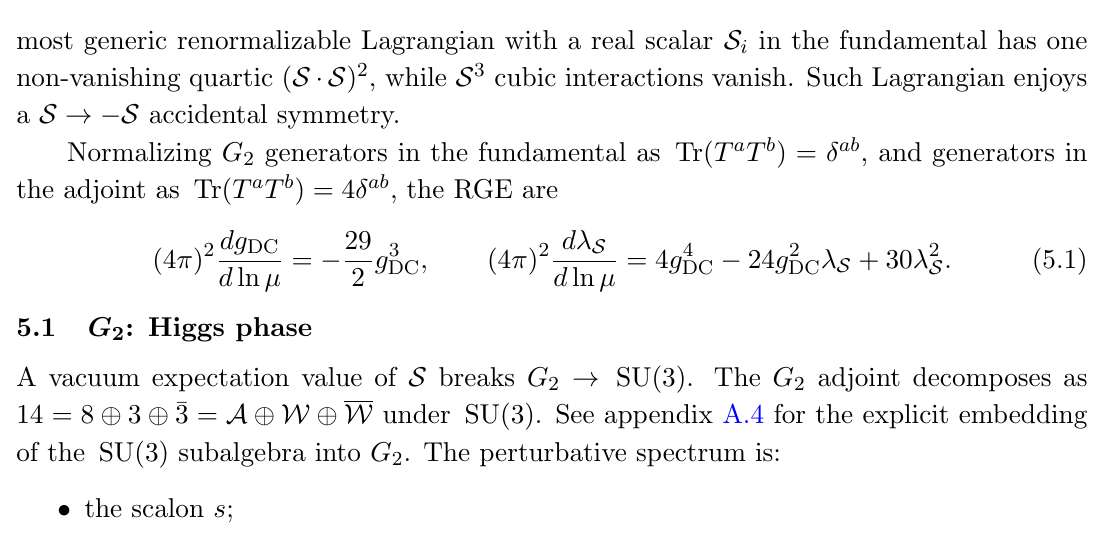
Figure 4 . As in (cid:12)gure 1, for Sp( N ) (left) and G 2 models